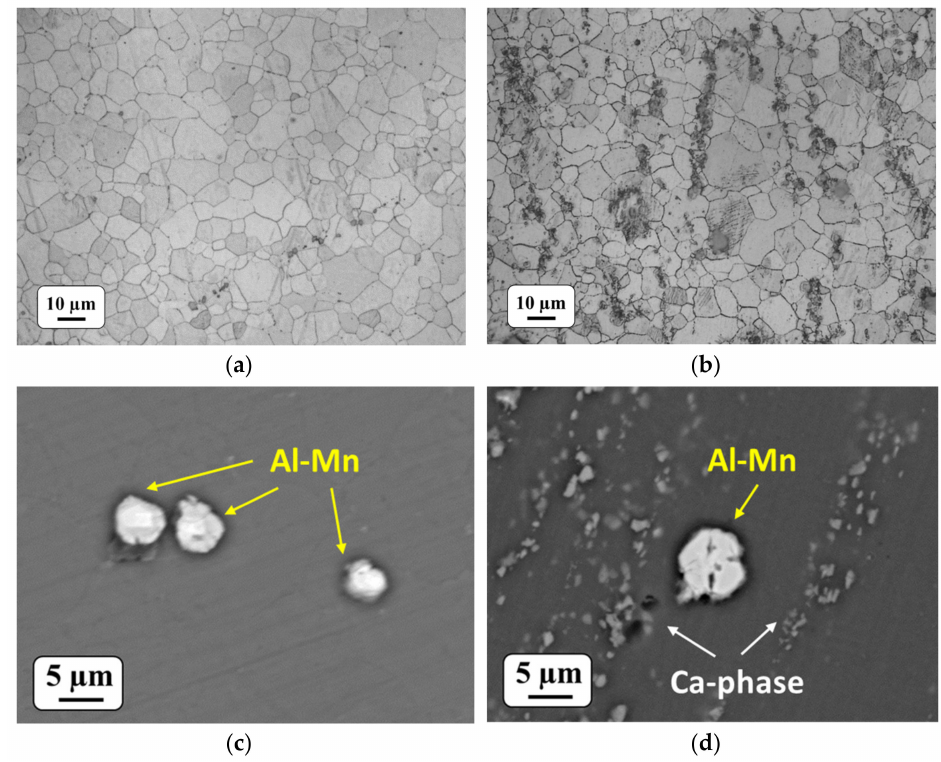
Figure 1. Typical microstructure of as-extruded: ( a , c ) AM60; ( b , d ) AMX601 alloys. XRD patterns of the as-extruded alloys in Figure 2 confirm the presence of the Al 8 Mn 5 phase. The additional peaks in the pattern of AMX601 alloy can be ascribed either to (Mg-Al) 2 Ca or to Mg 2 Ca phases since both phases possess a similar crystal structure [51].